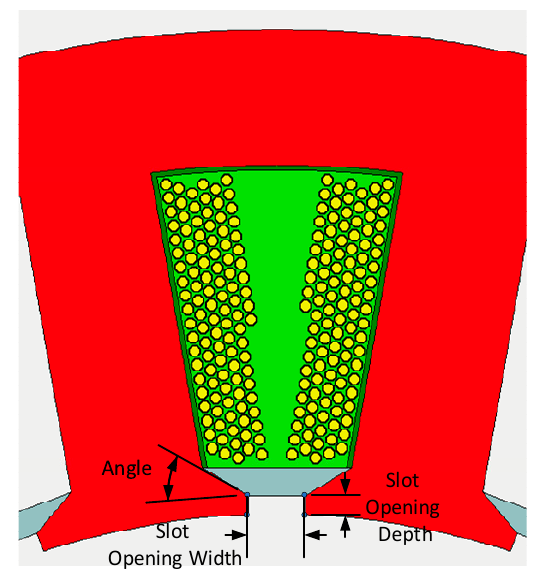
Figure 10. The slot opening dimensional parameters.